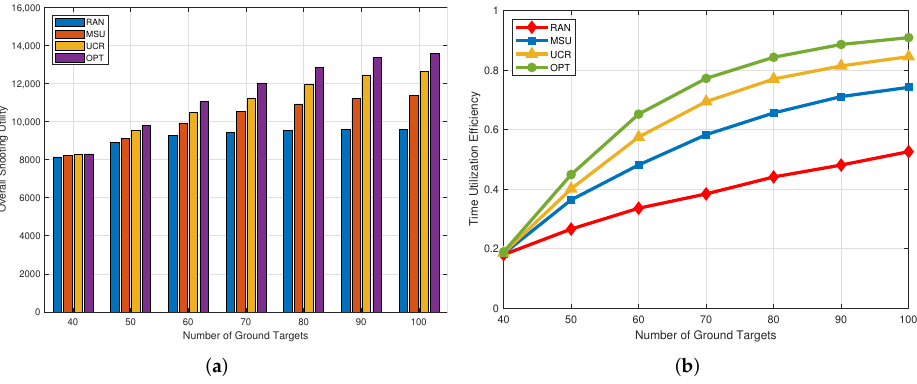
Figure 3. Impact of the number of targets. ( a ) Overall shooting utility; ( b ) Time utilization efficiency.